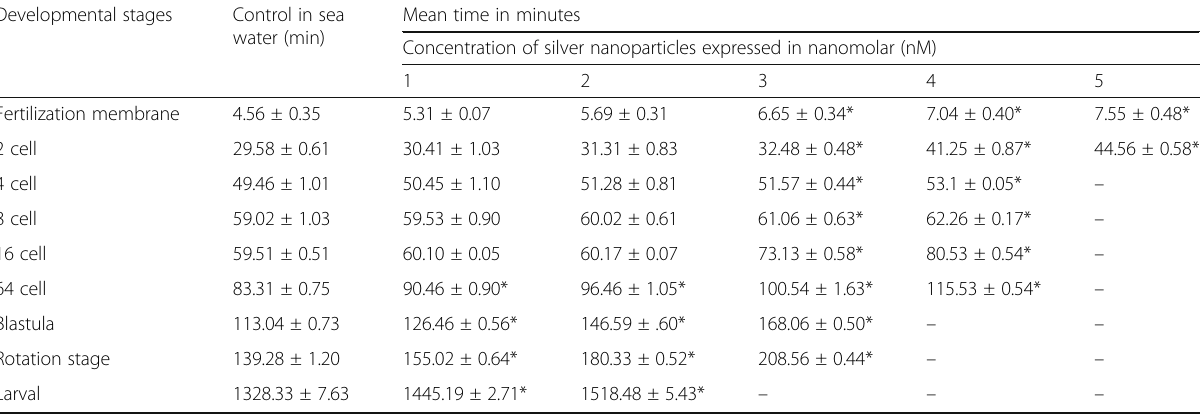
Table 1 Effect of silver nanoparticles on fertilization cumulative time of Hydroides elegans Developmental stages